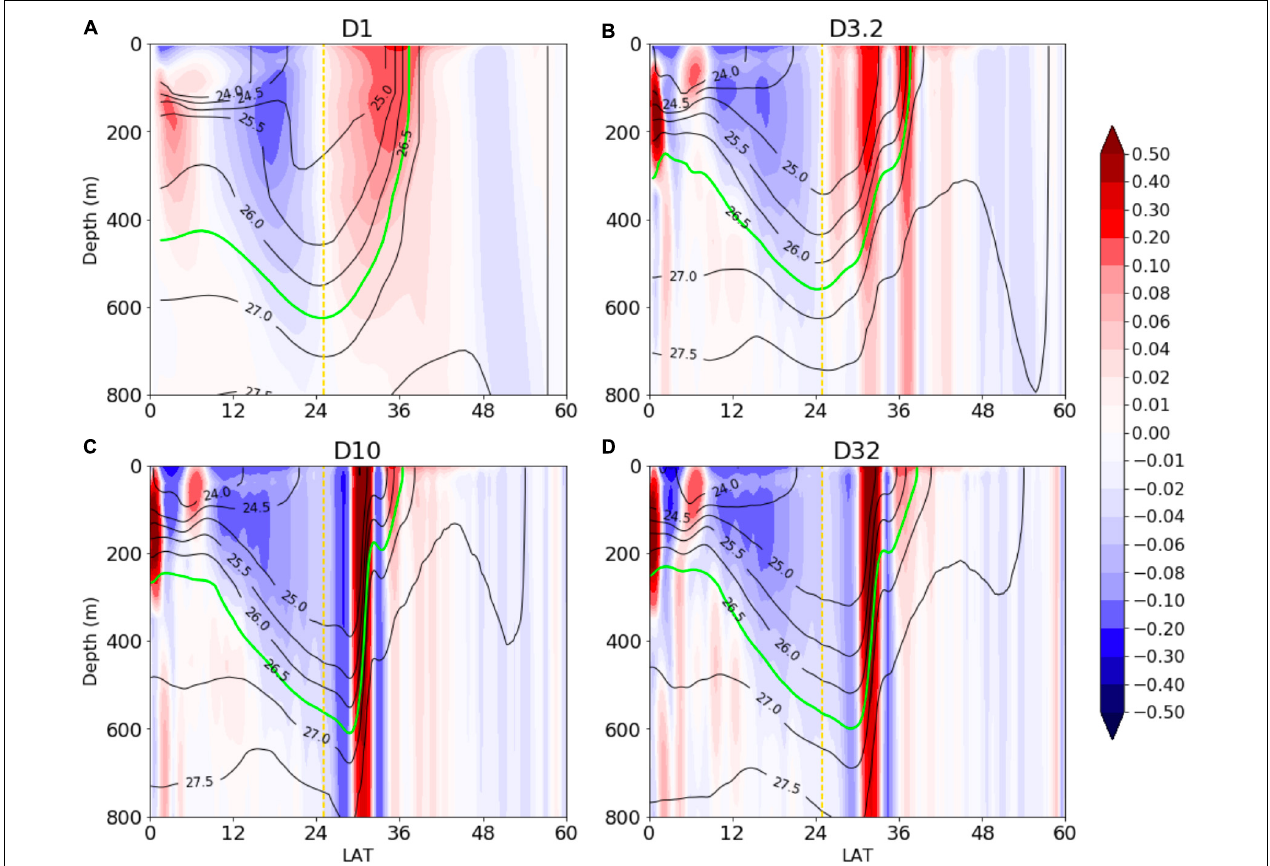
FIGURE 7 | Meridional sections of zonal velocity (colored, in m s − 1 ) and density (contoured) along 12 ◦ E, with the green line marking the main thermocline. The yellow dashed line represents the latitude of the maximum wind stress curl. (A–D) Correspond to experiments D1, D3.2, D10, and D32,